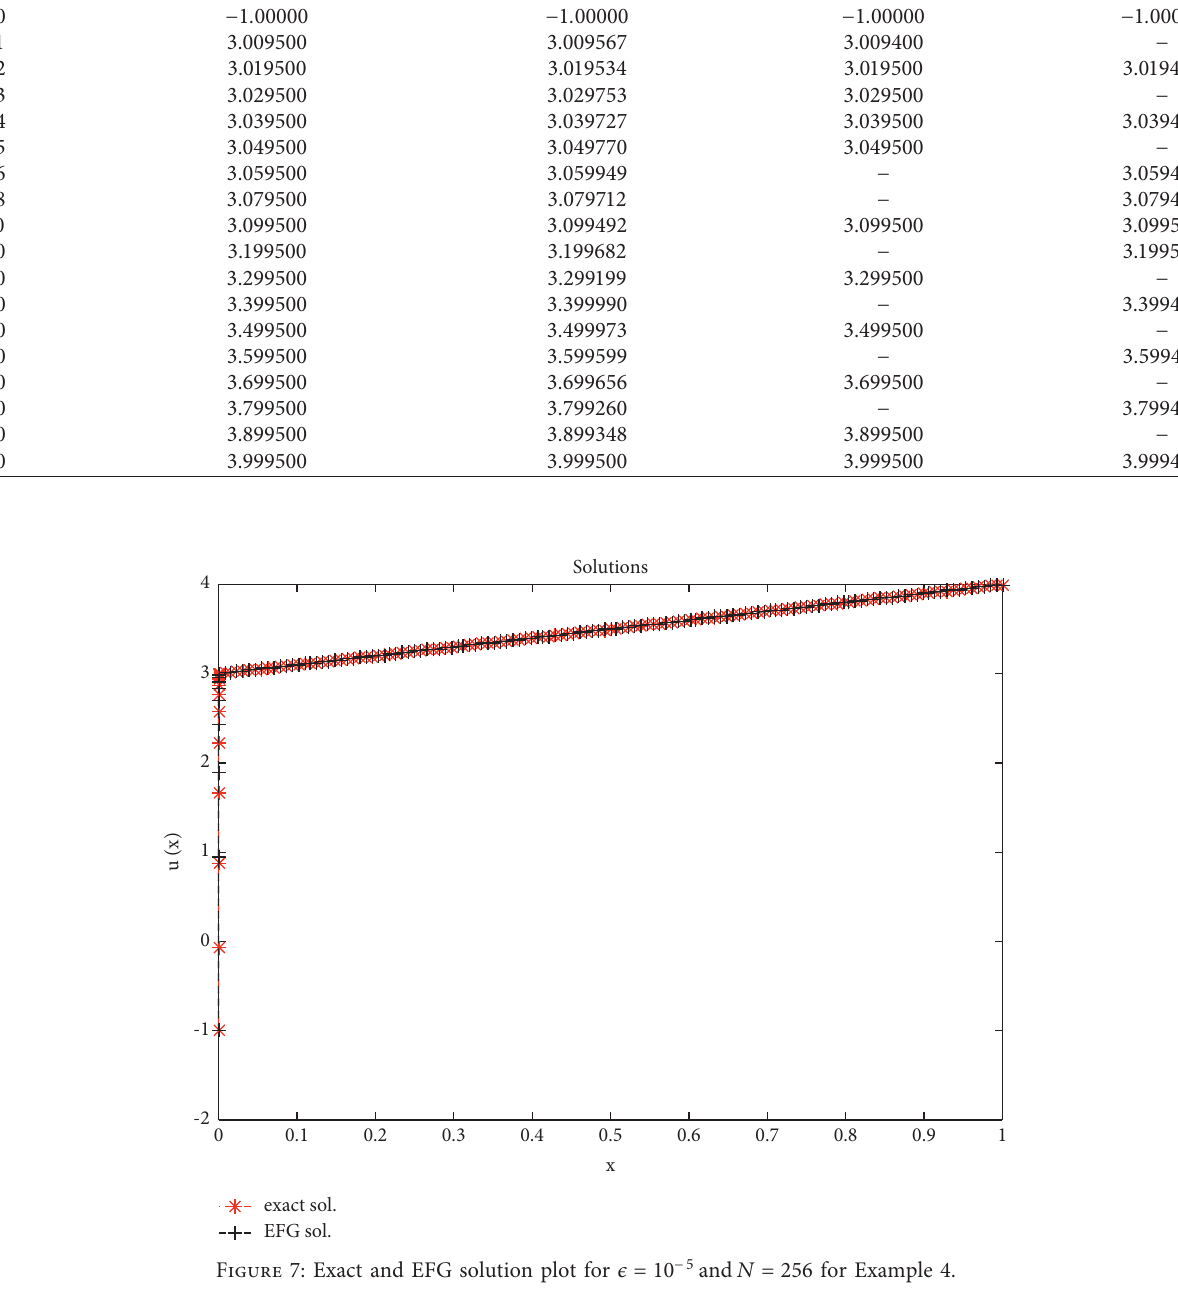
Table 12: Comparison of the EFG solution with exact and other scheme solutions of Example 4 for ϵ � 10 − 3 and N � 10 3 . x